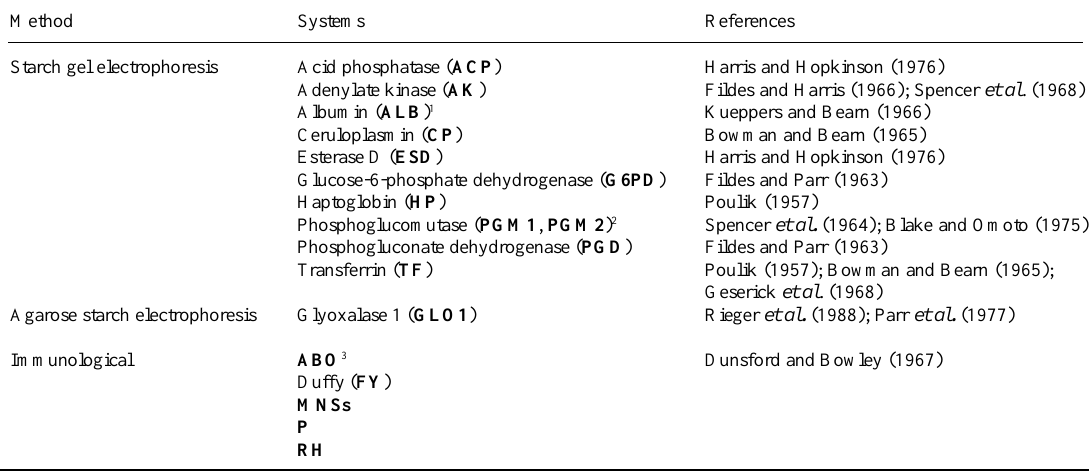
Table I - Genetic systems and laboratory methods employed in the present